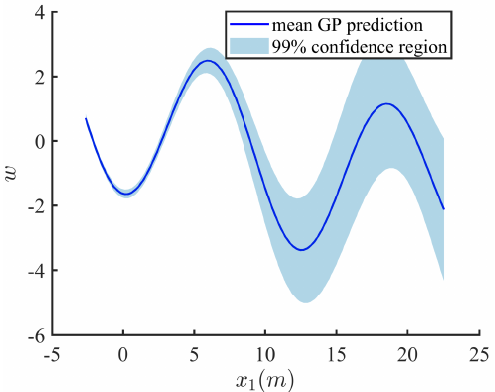
Figure 6. Gaussian process prediction